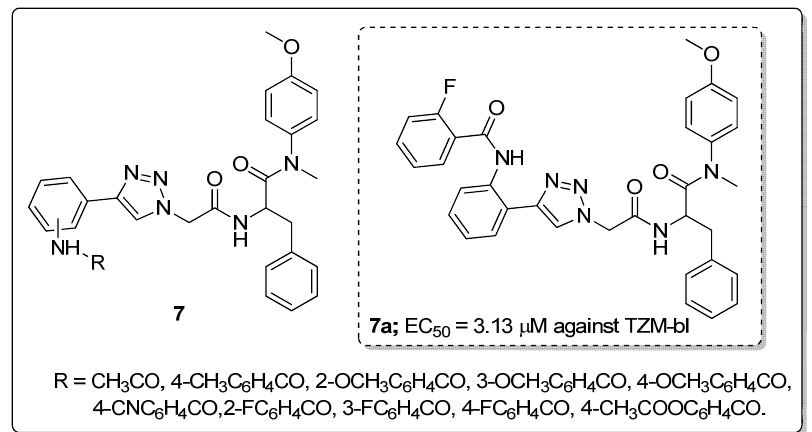
Figure 9. The anti-HIV activity of the most potent phenylalanine-1,2,3-triazole conjugate 7a . Figure 9. The anti ‐ HIV activity of the most potent phenylalanine ‐ 1,2,3 ‐ triazole conjugate 7a .